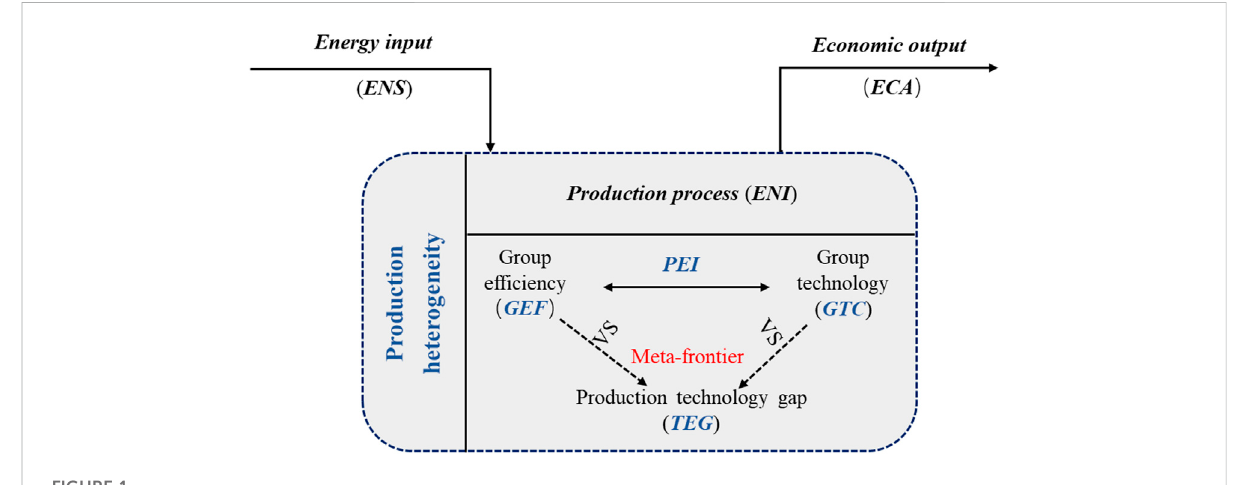
FIGURE 1 Process and in fl uencing factors of carbon